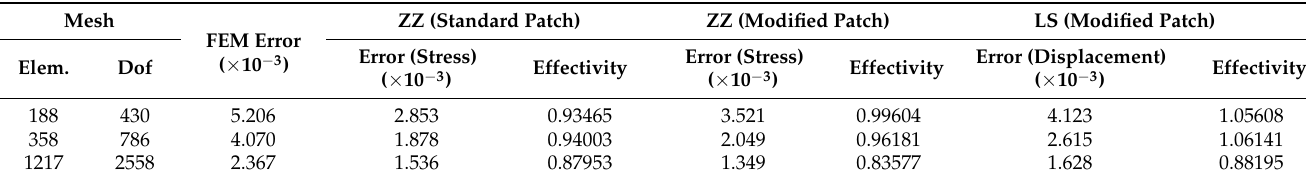
Table 9. Solution error and global effectivity for the plate with an opening problem using stress/displacement recovery and patch configuration (linear quadrilateral element).